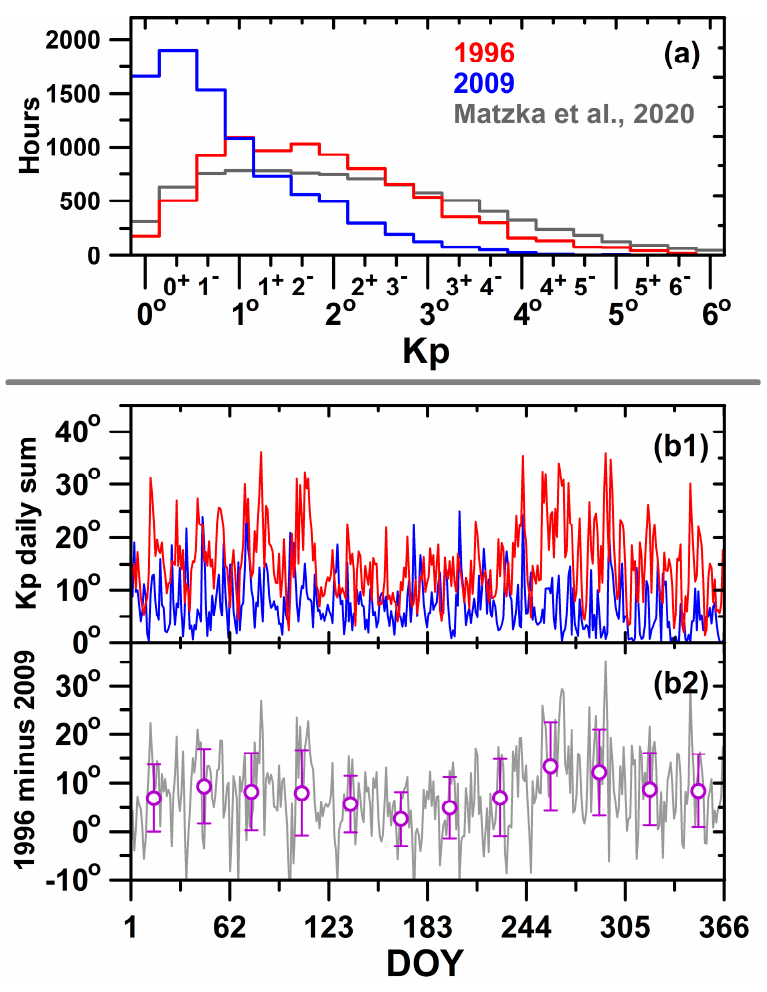
Figure 2 . Geomagnetic conditions of the periods in the study. Panel ( a ) shows the occurrence rate (in hours) of the Kp levels found in our data and those reported by [25]. Panel ( b1 ) are the Kp daily sum but is distributed along the year (day of the year—DOY), while panel ( b2 ) presents the 1996 minus 2009 Kp daily sum (the magenta dots denotes the monthly average, and the error bars indicate a 1 SD confidence interval).